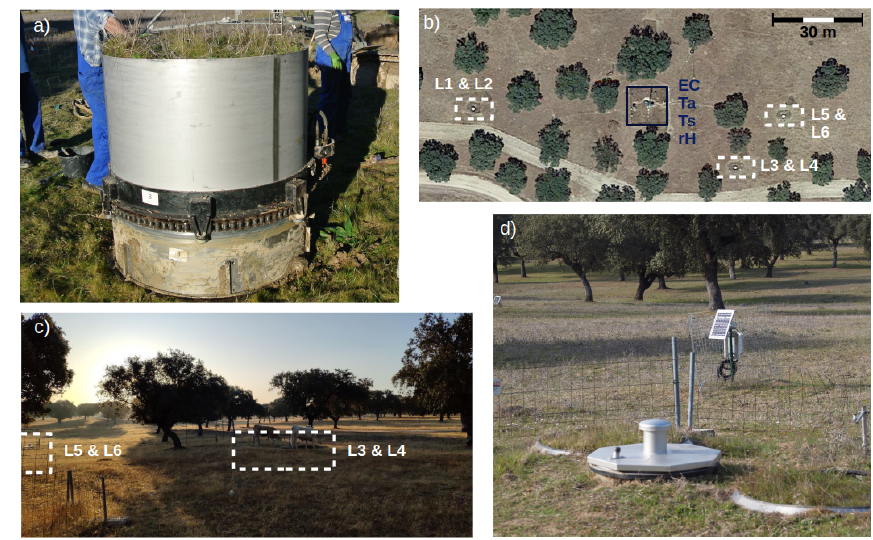
Figure A1. Pictures of an (a) intact, vegetated soil monolith in the lysimeter vessel after excavation for installation in 2015 (picture by Oscar Perez-Priego). (b) Aerial view of the measurement setup, with the lysimeter stations marked by white rectangles and the EC and me- teorological sensors marked by dark blue rectangles (map data from Google Earth; image from Instituto Geográfico Nacional). (c) Exemplar image of the site on 26 September at 08:30LT in the morning to illustrate the heterogeneous shading conditions caused by the singular stand- ing trees. (d) Lysimeter column 3 on 3 March 2022. The low fence around the station is installed to allow grazing of cows on the column, keeping them comparable with herbaceous vegetation outside the lysimeters, while reducing the risk of cows stepping on them (picture by Gerardo Moreno).